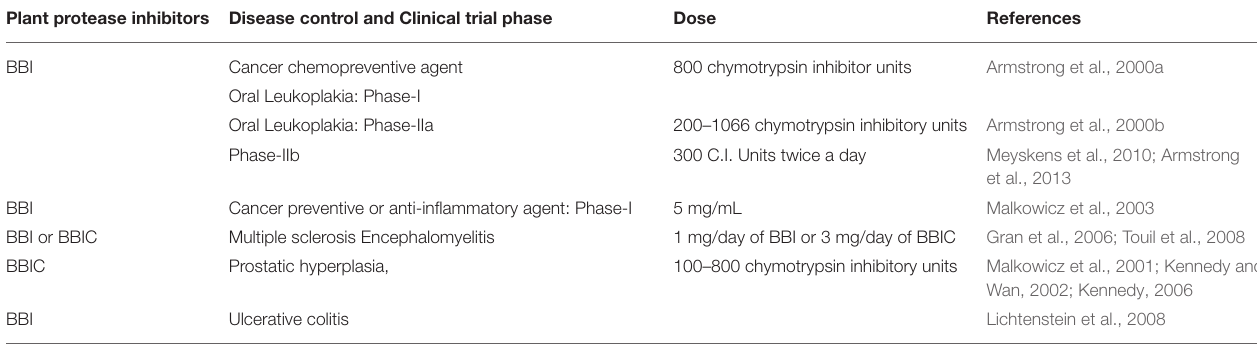
TABLE 2 | Soybean Bowman-Birk inhibitor (BBI) in clinical studies. Plant protease inhibitors Disease control and Clinical trial